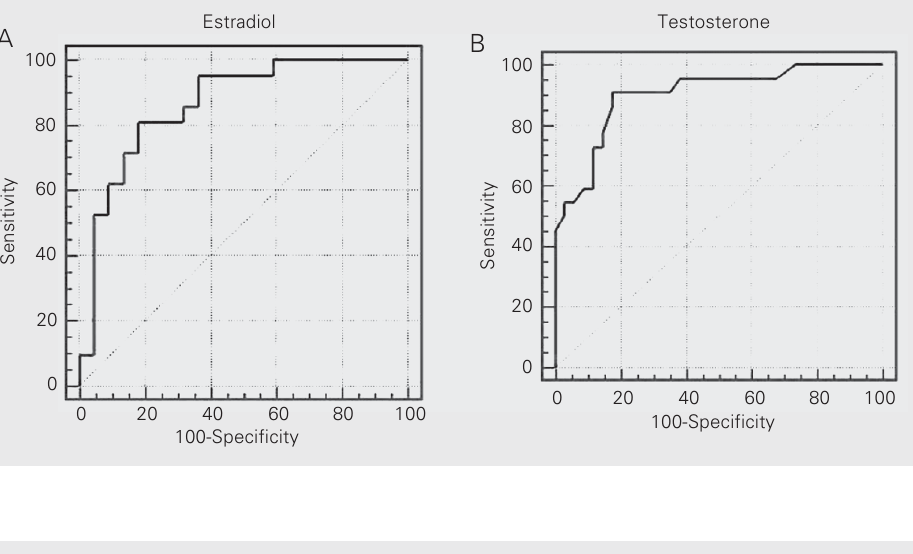
Figure 3. Progesterone/estradiol (P/E2), progesterone/testoster- one (P/T) and estradiol/testoster- one (E2/T) ratio in follicular fluid and degree of maturity of oo- cytes retrieved from patients with a cycle hyperstimulated with gonadotropins. The P/E2 (A), P/T (B) and E2/T (C) ratios were higher in the follicles con- taining mature oocytes than in the follicles containing imma- ture oocytes (*P < 0.05, Kruskal- Wallis and Mann-Whitney